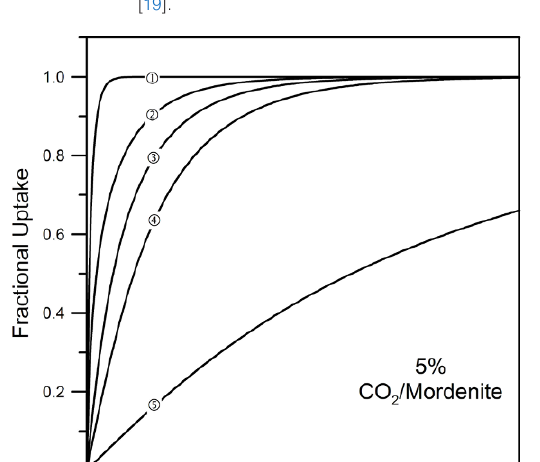
Figure 7. Theoretical kinetic isotherms of C NaX at 279 K calculated using Eq. 10 and the values of parameters collected in Tables 3 and 4. The bulk phase concentration is equal to 5% and the total bulk gas pressure is 101.325 kPa. The corresponding equilibrium adsorption data were reported by Costa et al . [19].